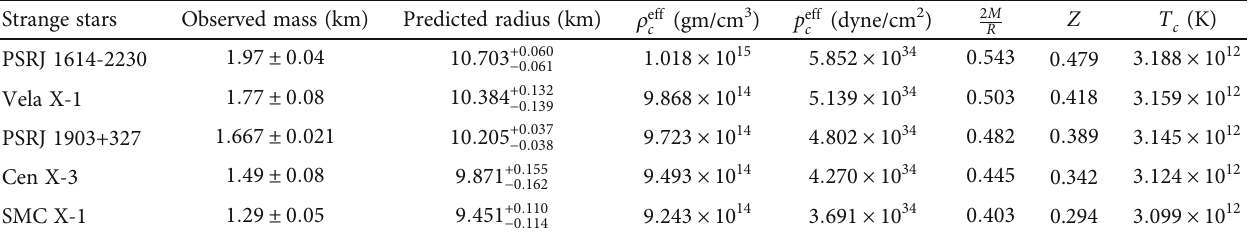
Table 1: Numerical values of physical parameters for the di ff erent strange star candidates for α = 0 : 06 and B = 83 MeV/fm 3 [24]. Strange stars Observed mass (km) Predicted radius